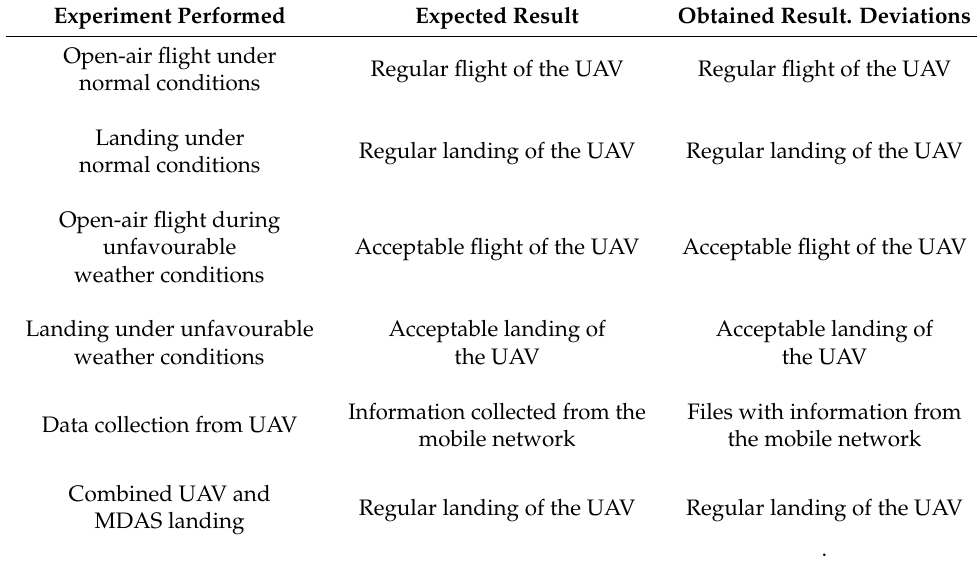
Table 7. Experiments carried out and comparison between expected and obtained results.